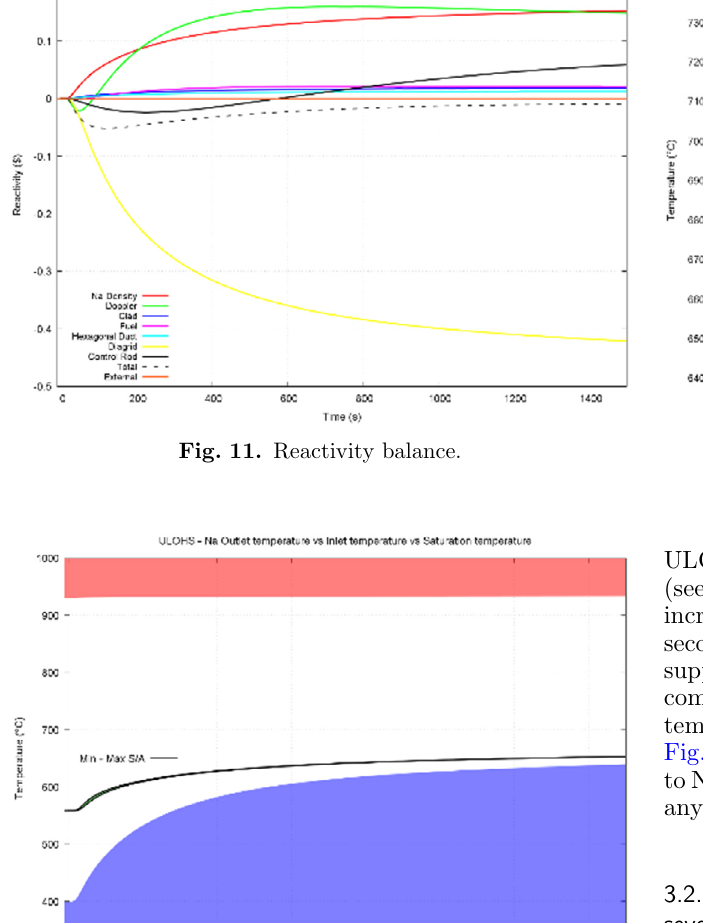
Fig. 10. Reactor power.